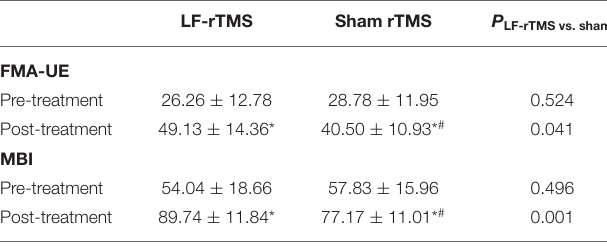
TABLE 2 | Comparison of the FMA-UE and the MBI scores between the LF-rTMS and the sham stimulation groups. LF-rTMS Sham rTMS P